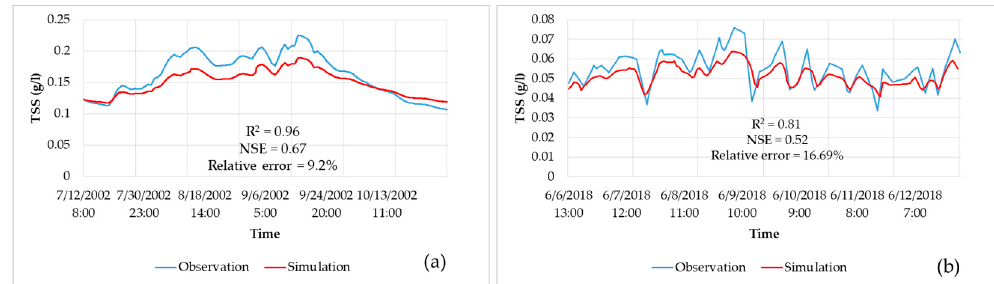
Figure 8. Observations and simulations at Tan Chau station for calibration TSS (g / l) ( a ) and validation TSS (g / l) ( b